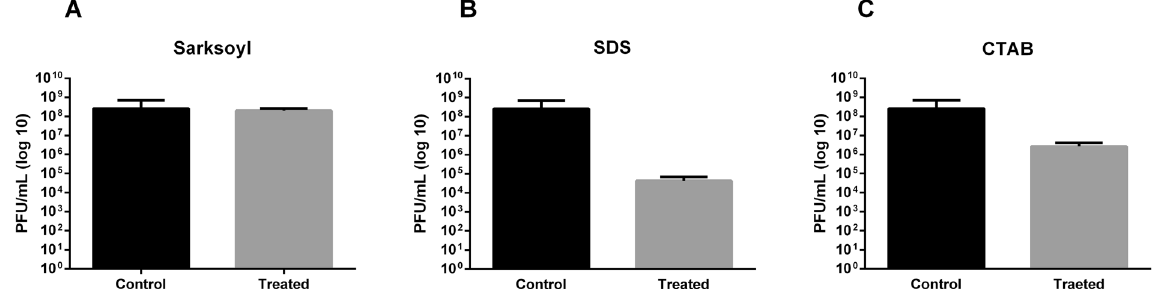
Figure 5. Viral stability under anionic and cationic detergents showed that vB_EcoM-UFV13 was sensible in all conditions.